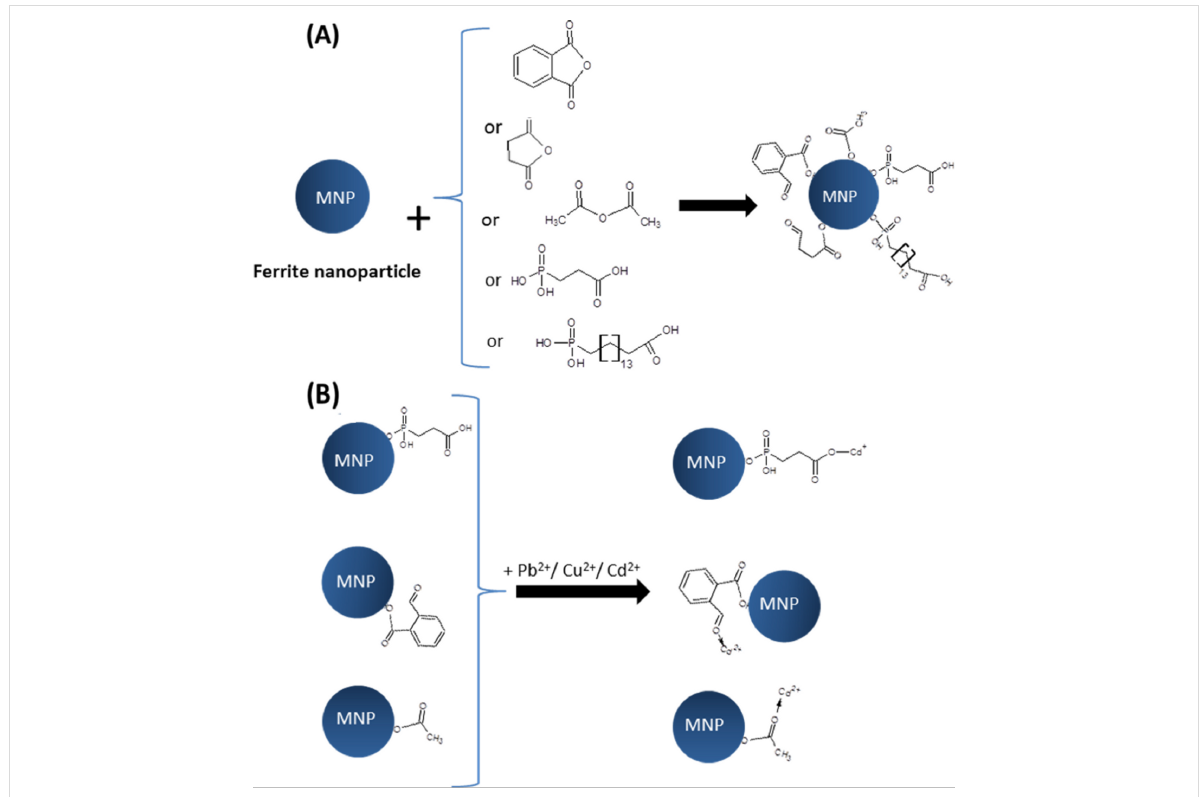
Figure 1: (A) Schematic presentation of the attachment of selected anhydrides and organophosphorus acids to the nanoparticles surface; (B) adsorp- tion of Cu 2+ , Cd 2+ or Pb 2+ to the nanoparticles surface via linkers (B).